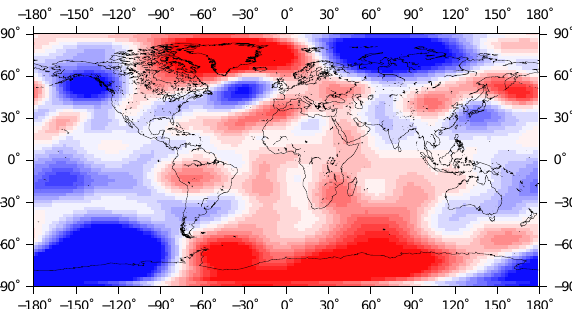
Fig. 4. ERA40 ψ 200 anomaly composite built from averaging ψ 200 anomalies over the years characterised by a frequency of HPE occurrence being in the upper 17% of the distribution. Contour in- terval 0.05 10 7 m 2 s − 1 .